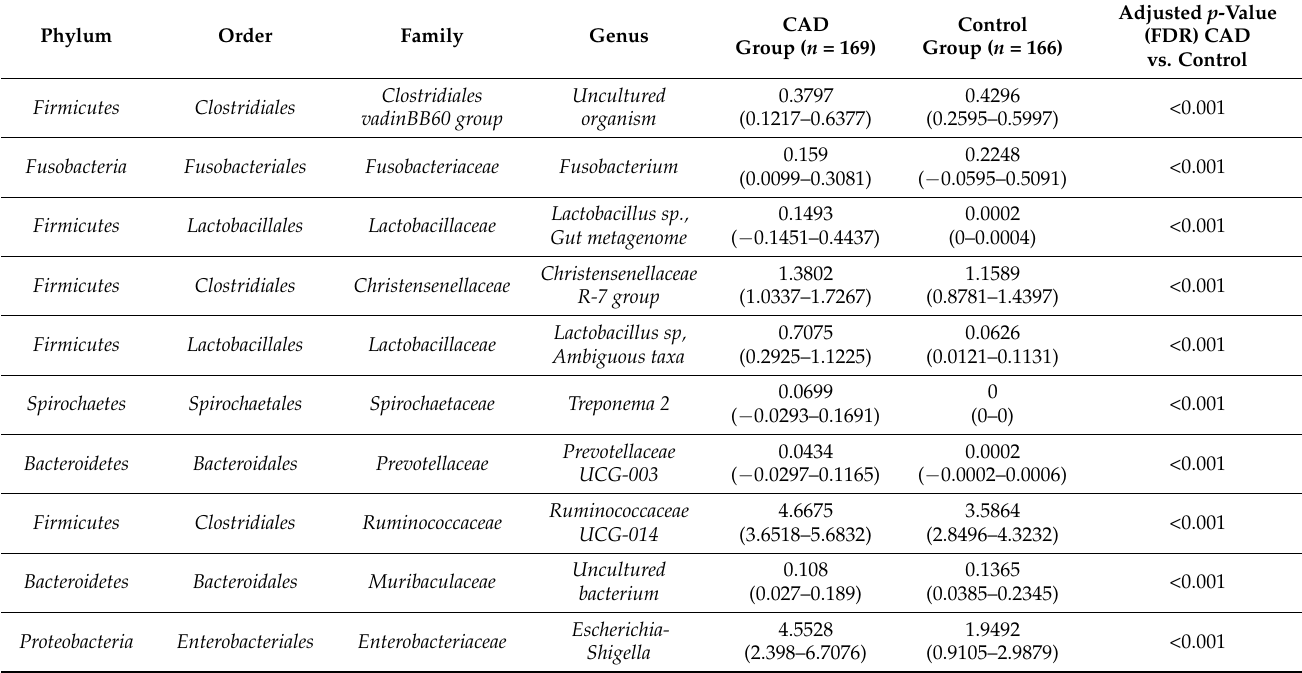
Table 5. OTUs with the highest statistical significance that differ between study groups.